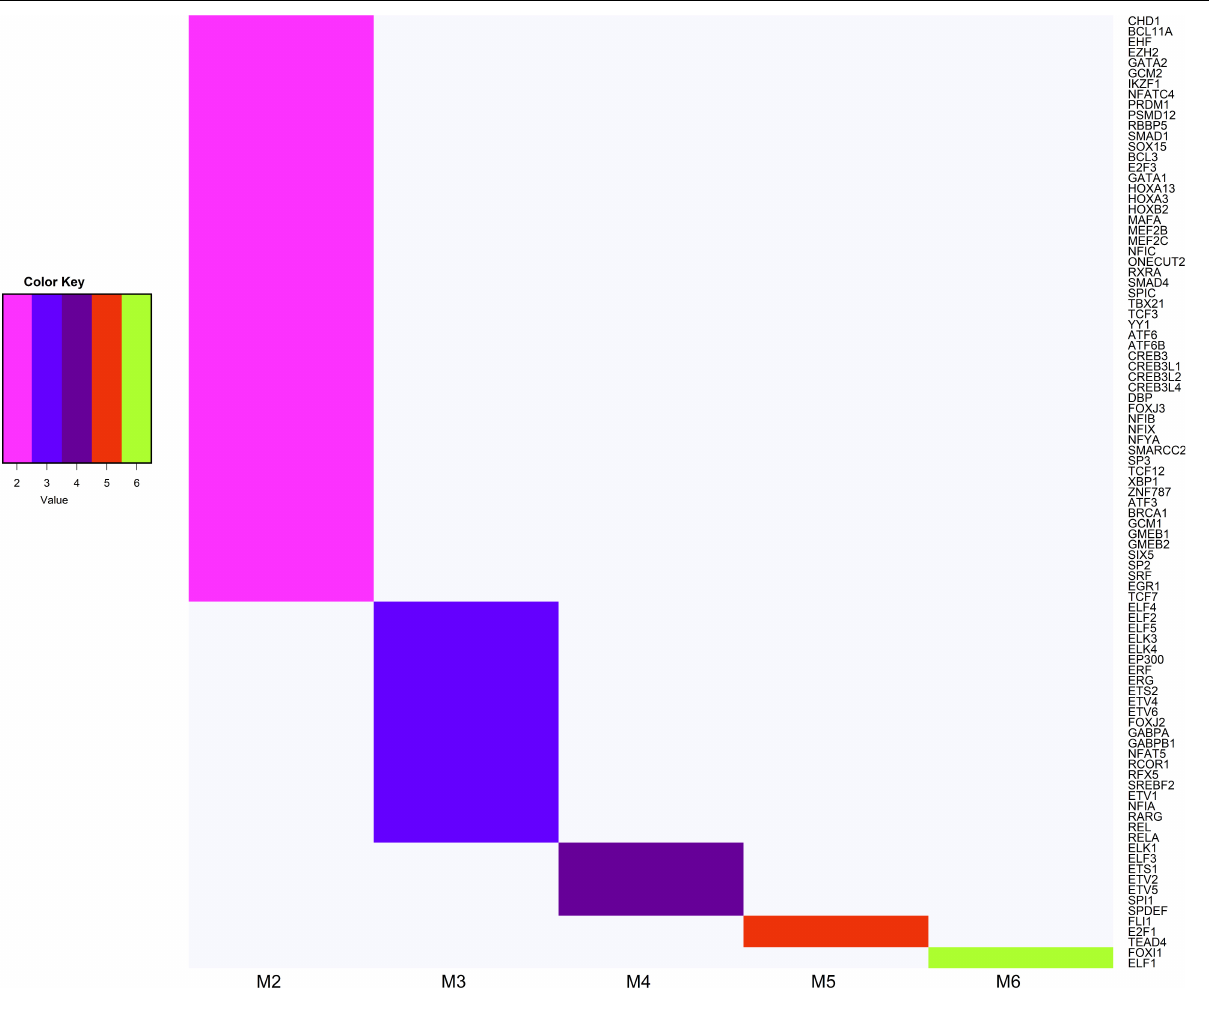
FIGURE 5 | Heatmap of transcription factors (TFs) that are potential regulators of hub genes belonging to at least two modules associated with feed efficiency-related traits. The TF gene names shown on the Y -axis, and the number of modules that the TFs interact is shown on the X -axis (M2 shown on pink = TFs interacting with two modules; M3 shown in blue = TFs interacting with three modules; M4 shown in purple = TFs interacting with four modules; M5 shown in red = TFs interacting with five modules; M6 shown in green = TFs interacting with six